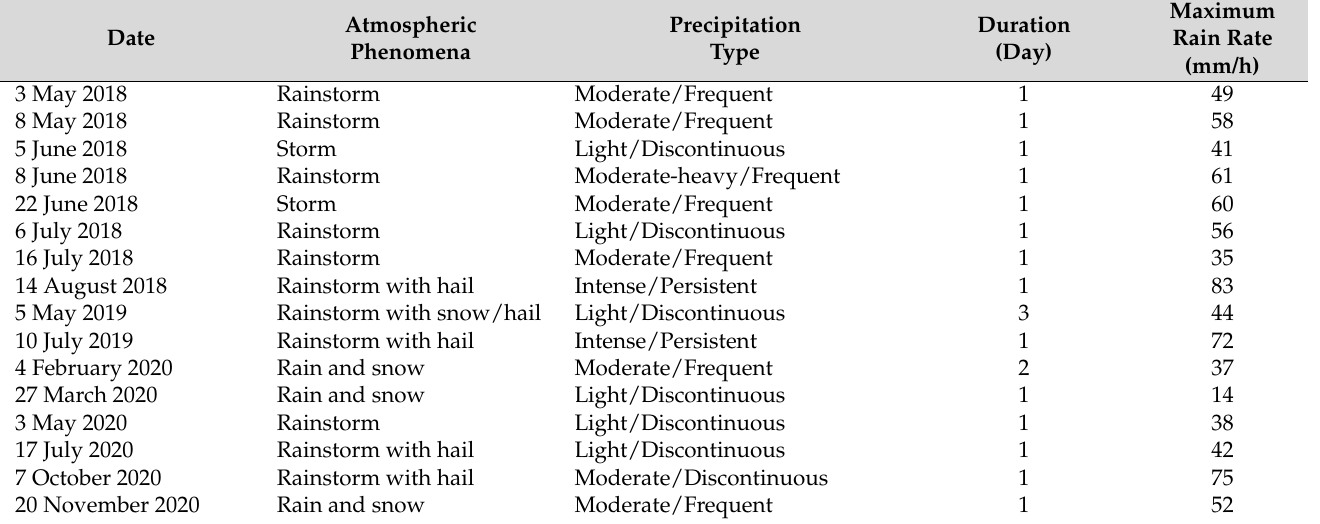
Table 4. Precipitation test cases in 2018–2020 within the Abruzzo domain used for intercomparing and validating the merging techniques listed in Table 3. Duration and maximum rain rate are derived from the rain gauge time series over the whole domain in Figure